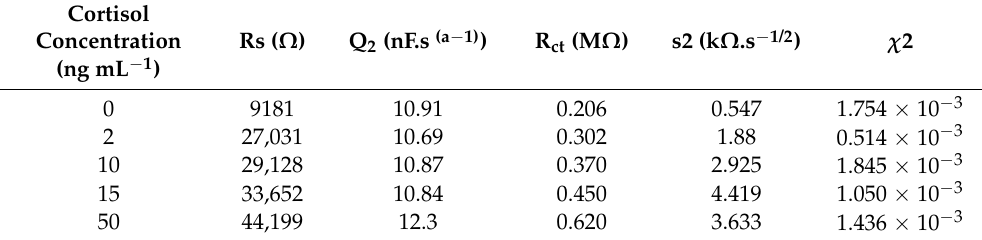
Table 1. Fitting parameters obtained from the equivalent circuit of the cortisol-based HfO 2 im- munosensor.